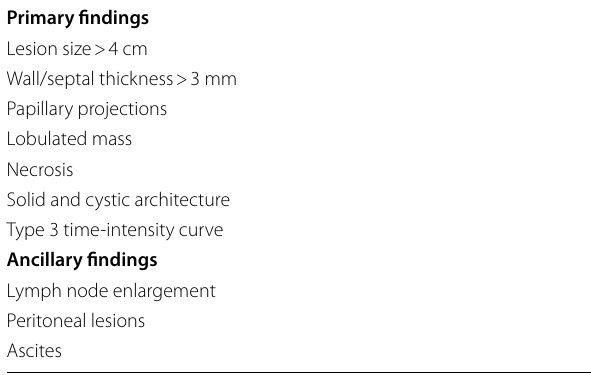
Primary and ancillary findings used for prediction of malignancy based on the literature review [2, 6]